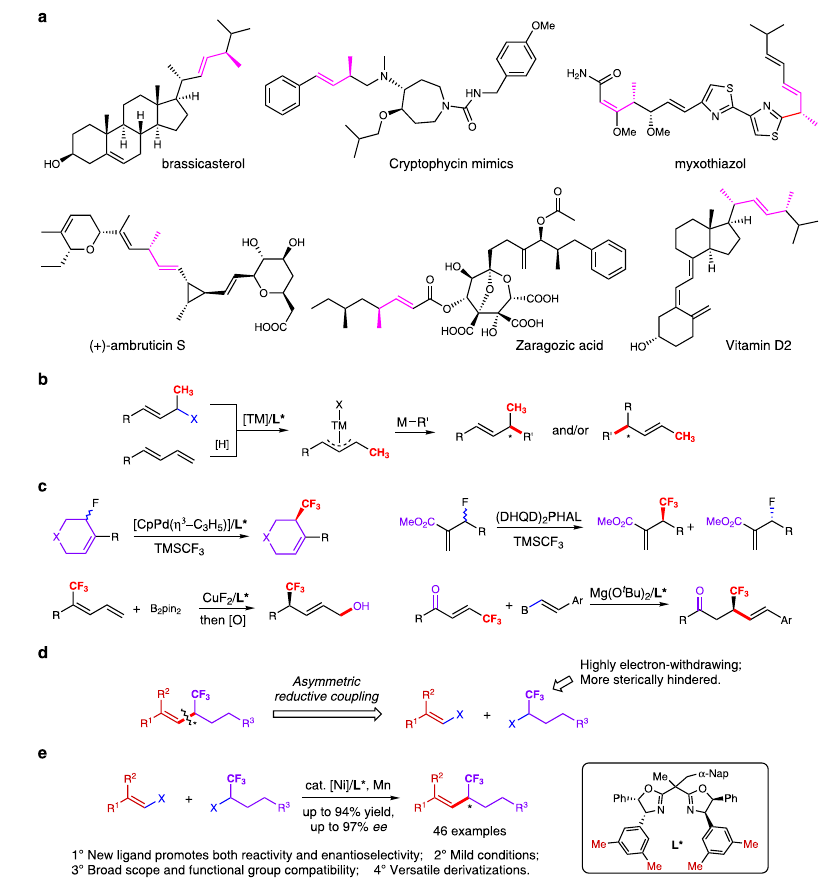
Fig. 1 | Asymmetric synthesis of enantioenriched ole fi ns featuring allylic (tri- fl uoro)methyl stereocenters. a Stereochemically complex biologically important molecules bearing allylic methyl stereocenters. b Strategies for accessing enan- tioenriched ole fi ns bearing allylic methyl stereocenters. c Known strategies for